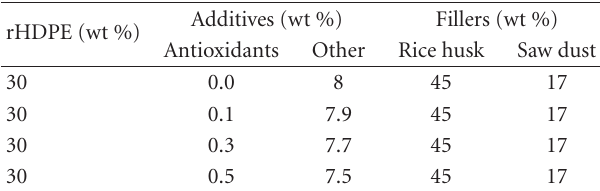
Table 1: Formulation of natural filler rHDPE composites. rHDPE (wt